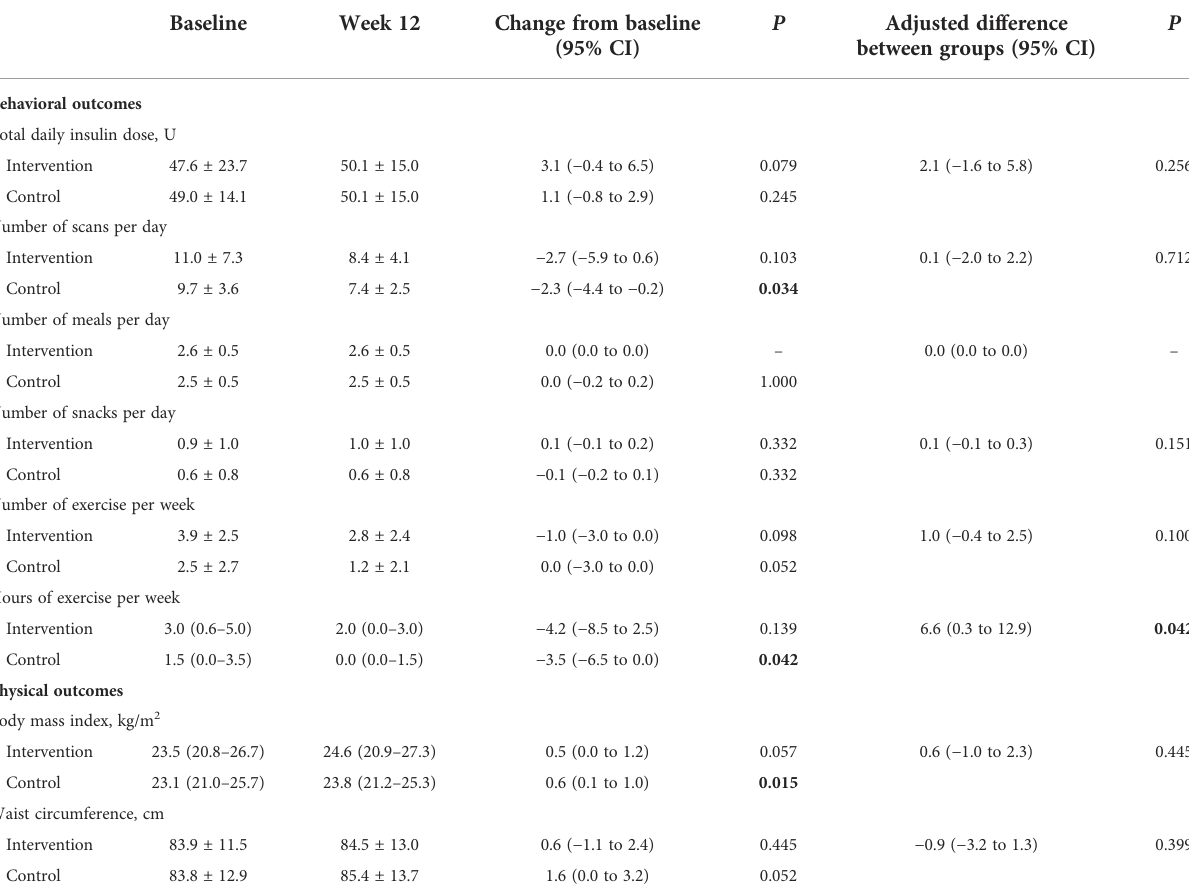
TABLE 4 Changes in behavioral and physical outcomes. Baseline Week 12 Change from baseline